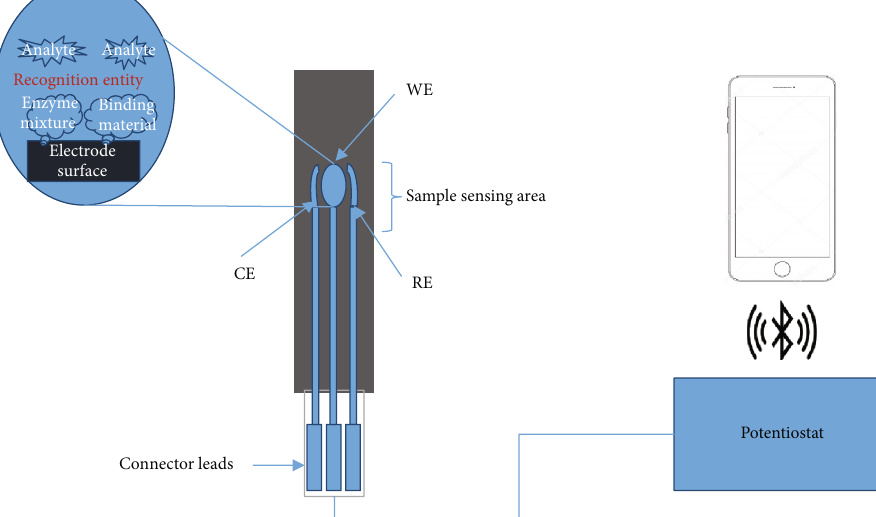
Figure 2: Schematic representation of the screen-printed electrode